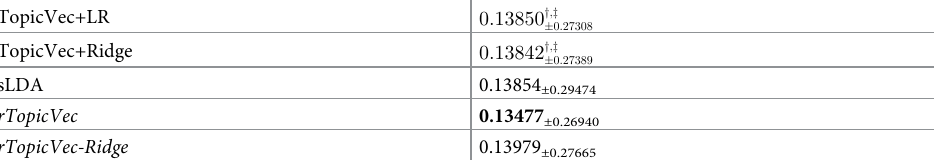
� 0 : 27308 0.13979 ±